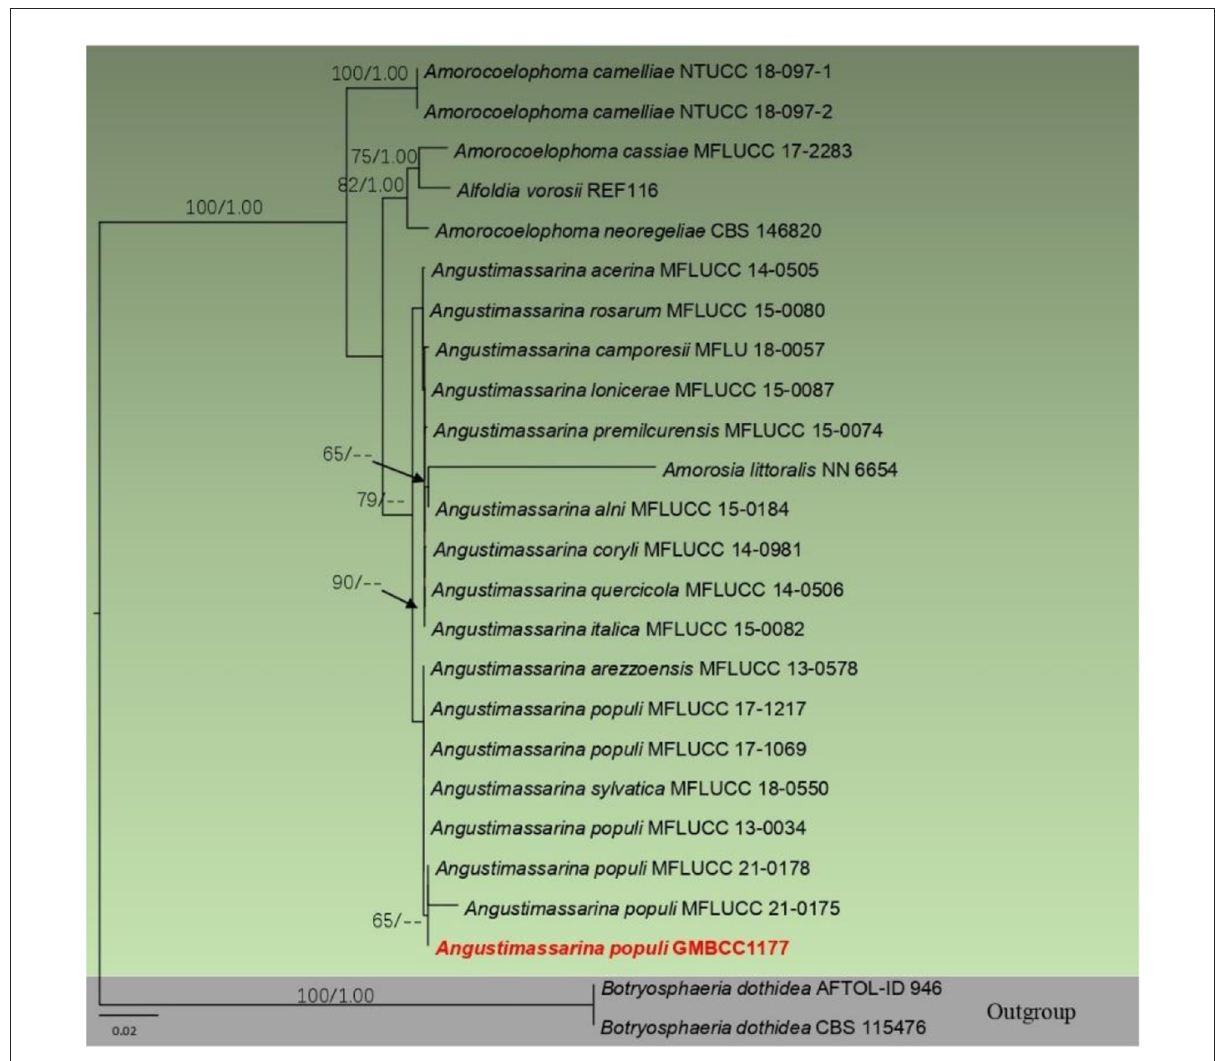
FIGURE2 Phylogram generated from maximum likelihood analysis based on combined SSU, LSU, tef1 , and ITS partial sequence data. Bootstrap support values for ML equal to or > 50% and BYPP values equal to or > 0.9 are given above the nodes. The newly generated sequence is in